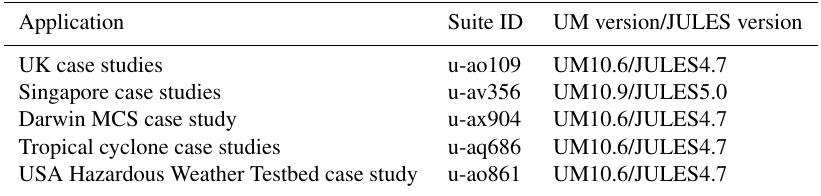
Table 3. Identifiers for a set of RAL1 reference simulations across a number of systems and/or applications. These suites are held on the Met Office Science Repository Service, which also holds the UM and JULES